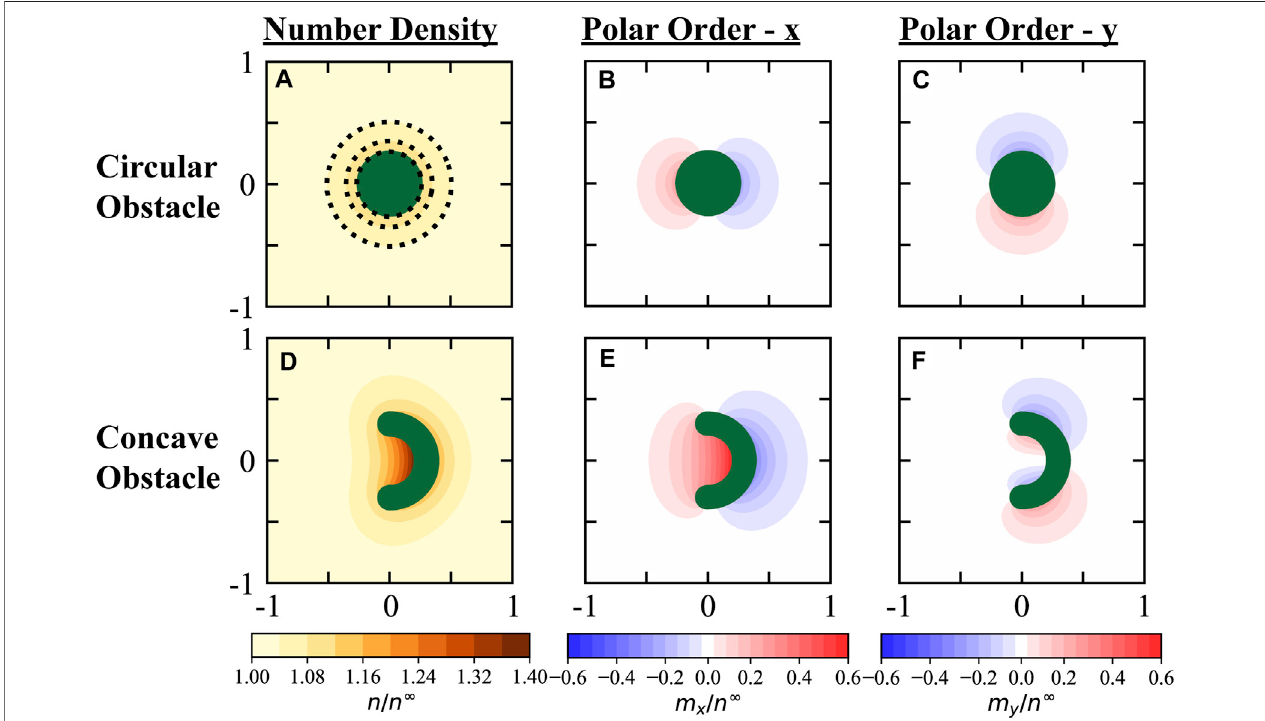
(cid:6)(cid:6) √ 7 /4)withdashed linestoguidethe